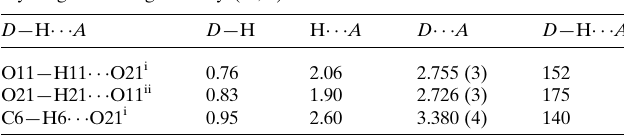
Table 1 Hydrogen-bond geometry (A˚ , (cid:3) ).